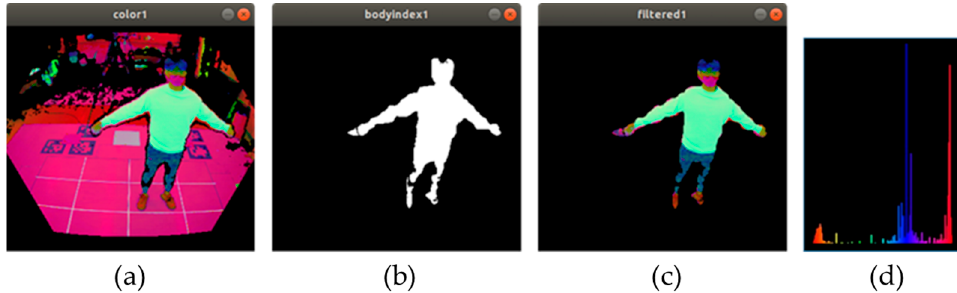
Figure 4. ( a ) Original hue image. ( b ) Body-index image. ( c ) Filtered body-index hue image. ( d ) Cal- culated histogram.